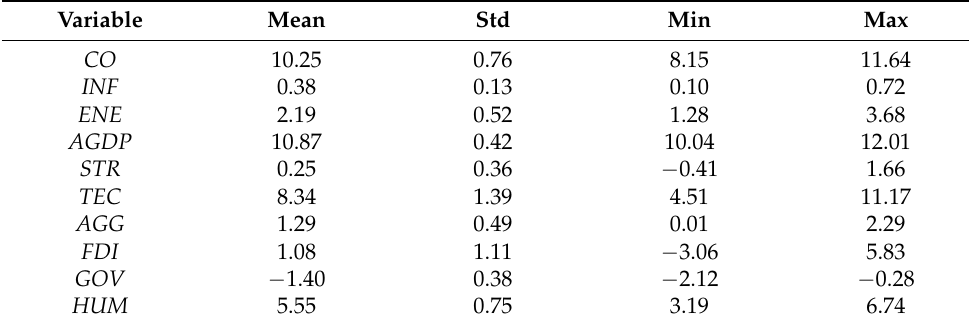
Table 3. Descriptive statistics of the